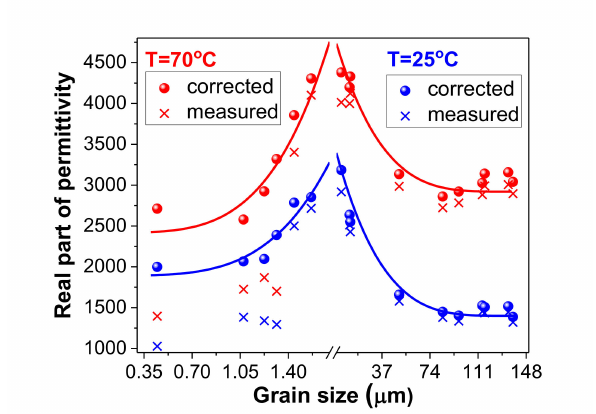
Figure 4. Estimated dependences of the dielectric constant on grain sizes by finite element method (FEM) simulations for fully dense BaZr 0.05 Ti 0.95 O 3 ceramics (the continuous lines are guides for the eye) and comparisons with experimental data.